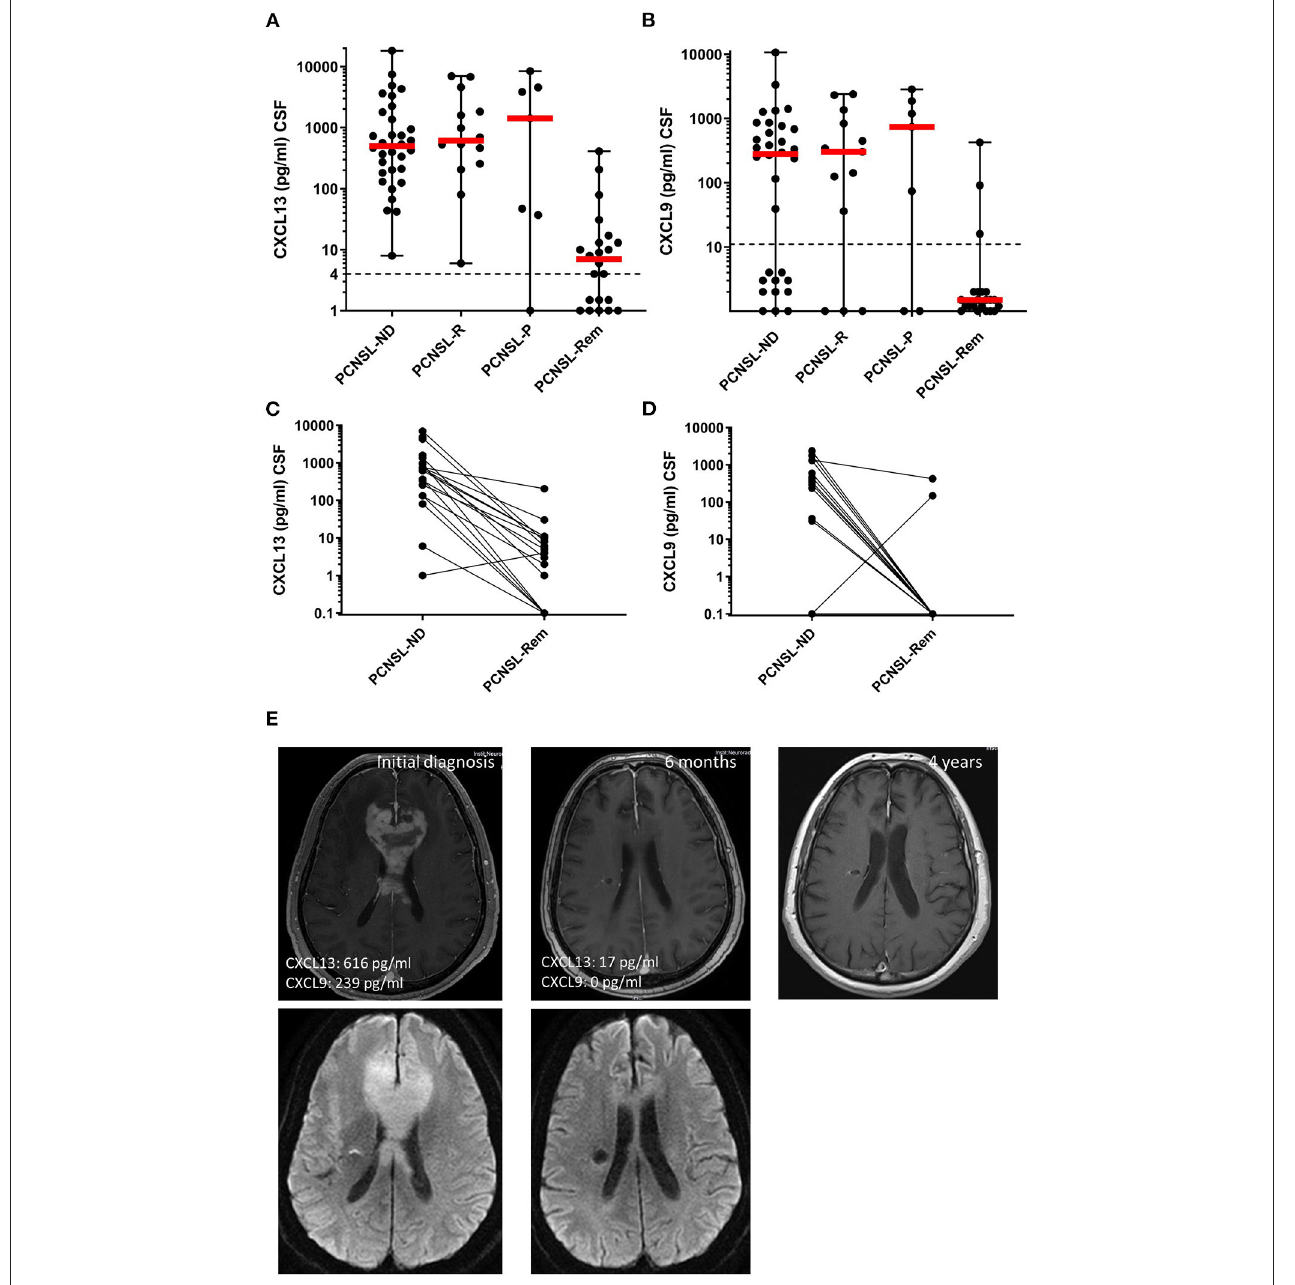
FIGURE 3 | CXCL13 and CXCL9 as disease monitoring and prognostic markers. (A,B) CXCL13 and CXCL9 CSF levels were compared between patients with newly-diagnosed PCNSL (PCNSL-ND), PCNSL in relapse (PCNSL-R), PCNSL with disease progress during therapy (PCNSL-P), and PCNSL in remission (PCNSL-Rem). The dotted line in each diagram depicts the detection limit of each chemokine. Values below the detection limit were counted as 0 for calculation processes but were assigned different values in the diagram for better visualization of the number of probes below the limit. (C,D) CXCL13 and CXCL9 CSF levels were compared in patients with PCNSL before and after 6 cycles of chemotherapy, where the disease was declared to be in remission by MRI and CSF withdrawal. (E) MRI images of a patient with CNSL upon initial diagnosis (left), remission after 6 cycles of chemotherapy (middle), and long-term remission 3 years later